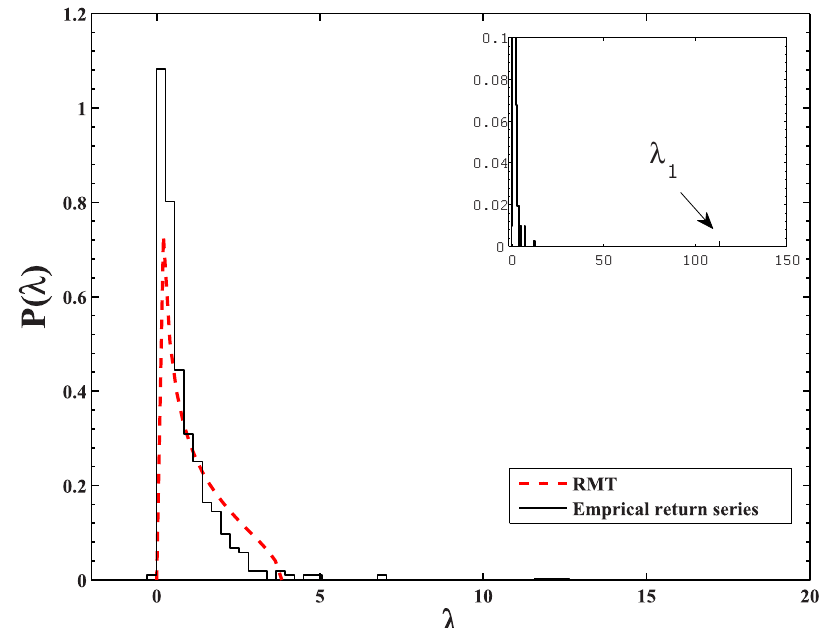
Figure 5. Comparison between the eigenvalues of empirical correlation matrix and random correlation matrix. Probability density function (PDF) P ( l ) of the eigenvalues of the correlation matrix constructed from the return series of 367 A-Share stocks in the first moving window form 04/01/1999 to 06/09/2000. The dotted line is the analytical result of RMT obtained from equation (3). The inset shows the largest eigenvalue l 1 of the empirical return series, which is much larger than the upper bound l max of RMT.